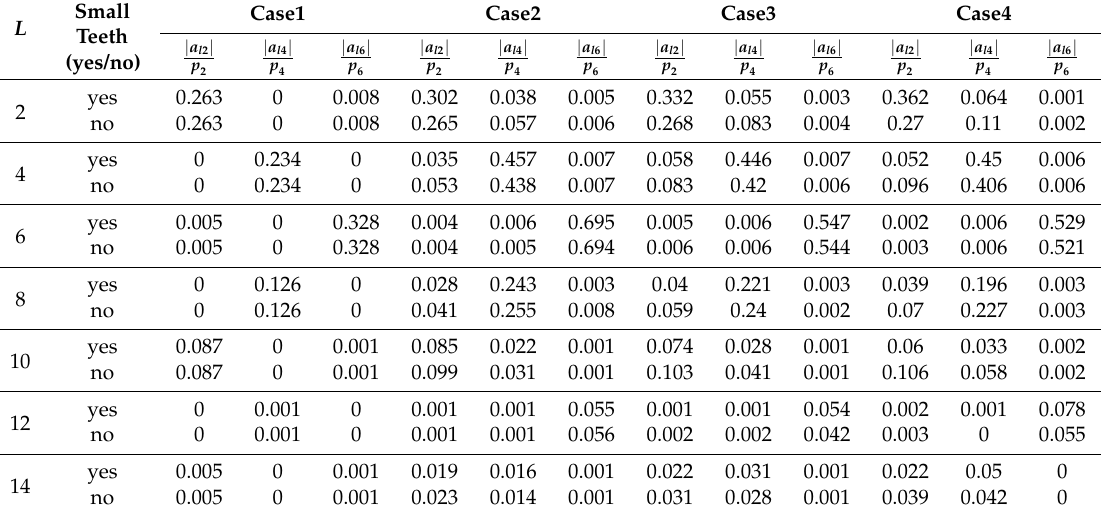
Table 9. Fourier expansion of p Y l in Cases 1–4.